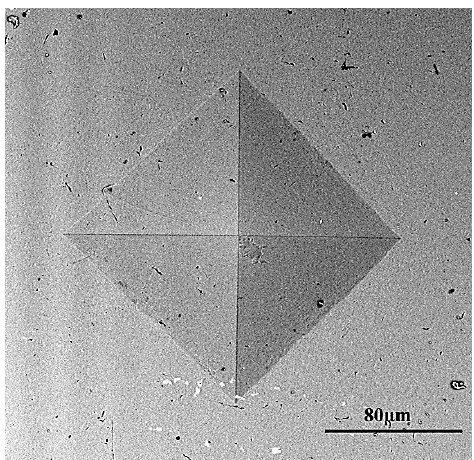
Figure 4. The topography of indentation under the test temperature of 800 °C (SEM).